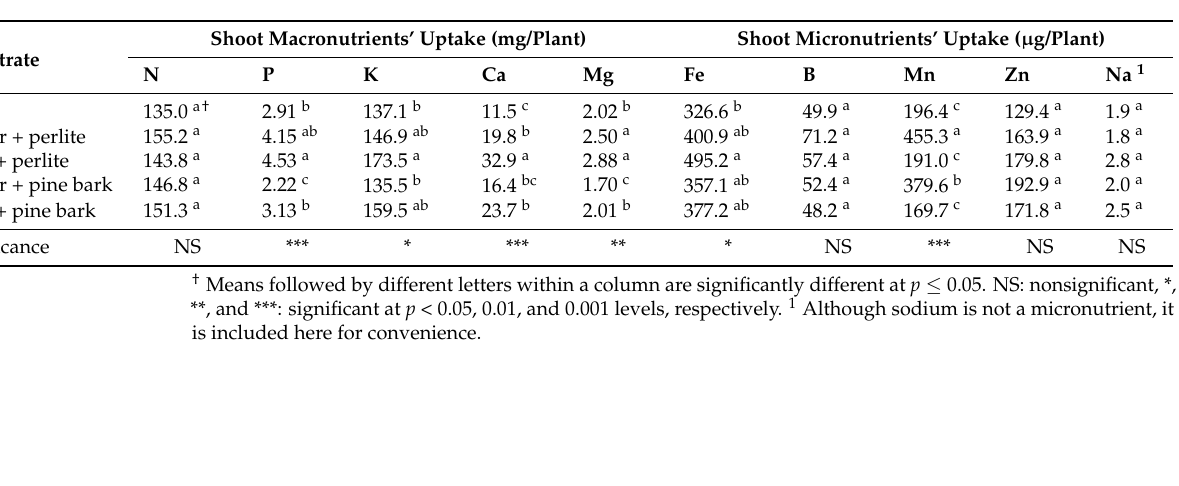
Table 3. Effects of the substrates on shoot nutrients’